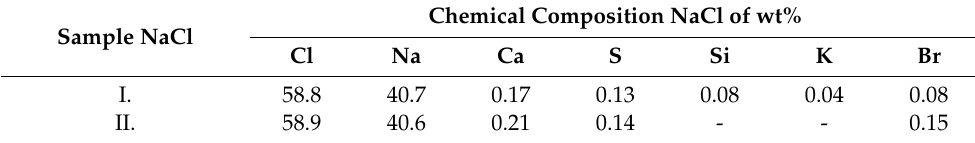
Table 1. Chemical composition of